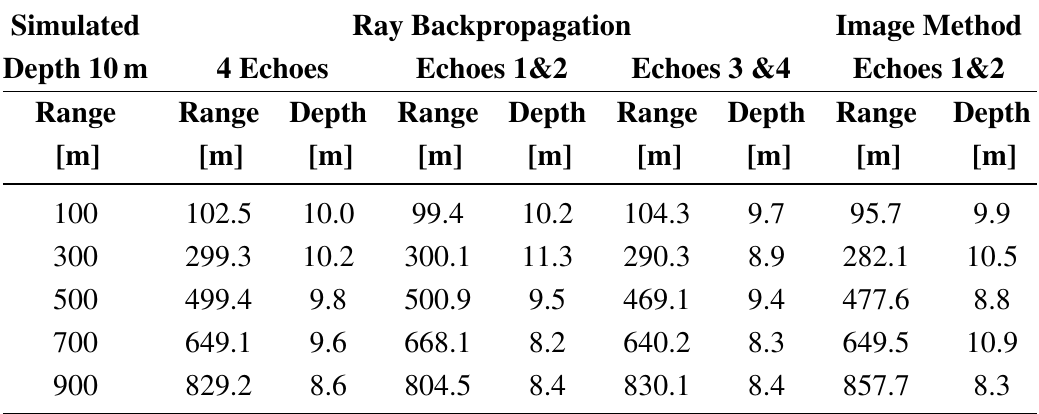
Table 2. Estimates of range and depth of a simulated source at 10 m depth, between a 100 and 900 m range from the receiver. The backpropagation method was applied to the four echoes, the earlier two echoes (1& 2) and the last two echoes (1& 2). The source image method was applied to the earlier two echoes. The range and depth estimates were obtained using estimates of the elevation angles from simulated data with 5 dB